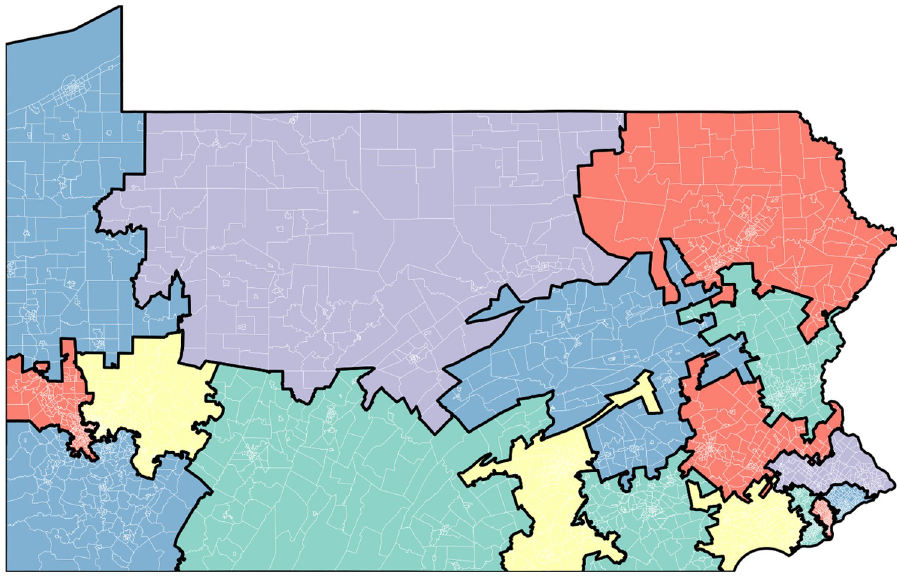
Fig 5. PA plan with two districts with more than 40% Black residents, a third district with 53.1% non-whites, and 35 county splits. The red district in the southeast on the southern border has a Black population that is 41.2% of the district’s total. The green district to the west and on the southeast border is 40.8% Black. In addition, the blue district to the east of the red district is 53.1% non-white. All other districts have a white majority of at least 60%. Philadelphia County is split into these three districts. The plan is contained in the file df2020-01-31x14x56x15x610108pc0.01x1618. csv, which is part of the repository of 11,206 plans